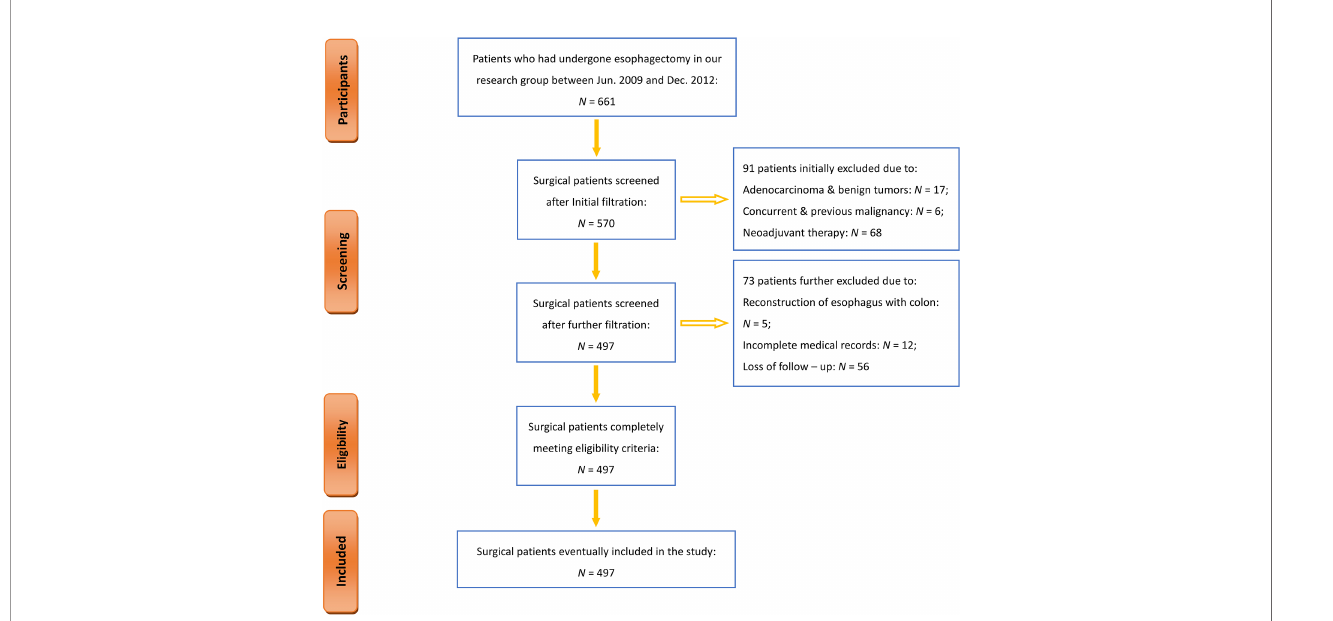
FIGURE 1 | Flowchart of the inclusion and exclusion of